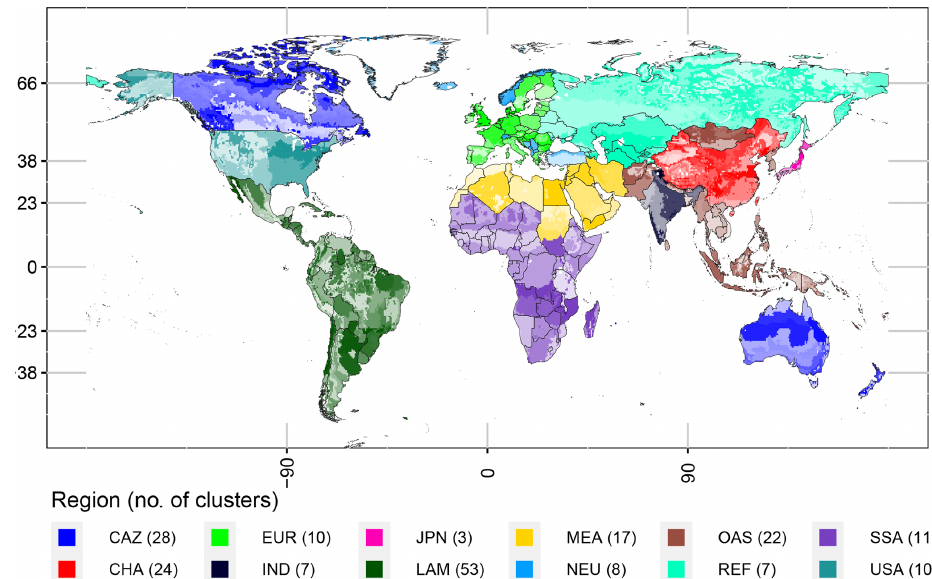
Figure 1. A total of 200 simulation clusters in MAgPIE based on Dietrich et al. (2020a) on a 0.5 ◦ resolution grid. Clusters in each region are plotted on a gradient from the darkest to lightest shade of color representing a region.